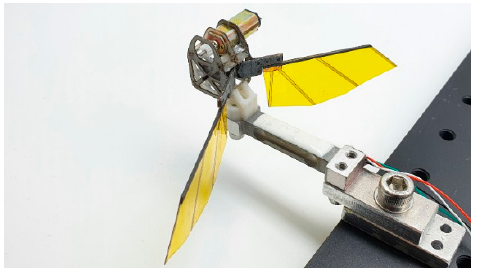
Figure 1. The developed prototype FWMAV based on flapping mechanism using a constrained spherical six ‐ bar